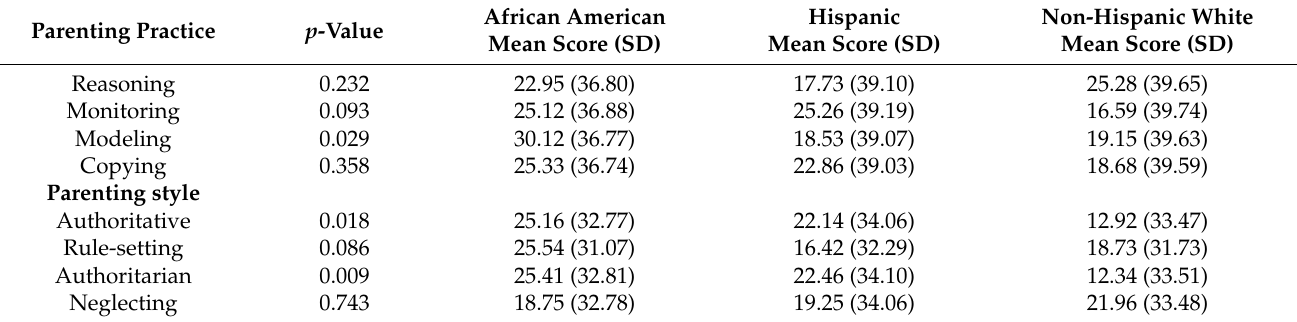
Table 5. Comparison of parenting practice and style scores by race/ethnicity.